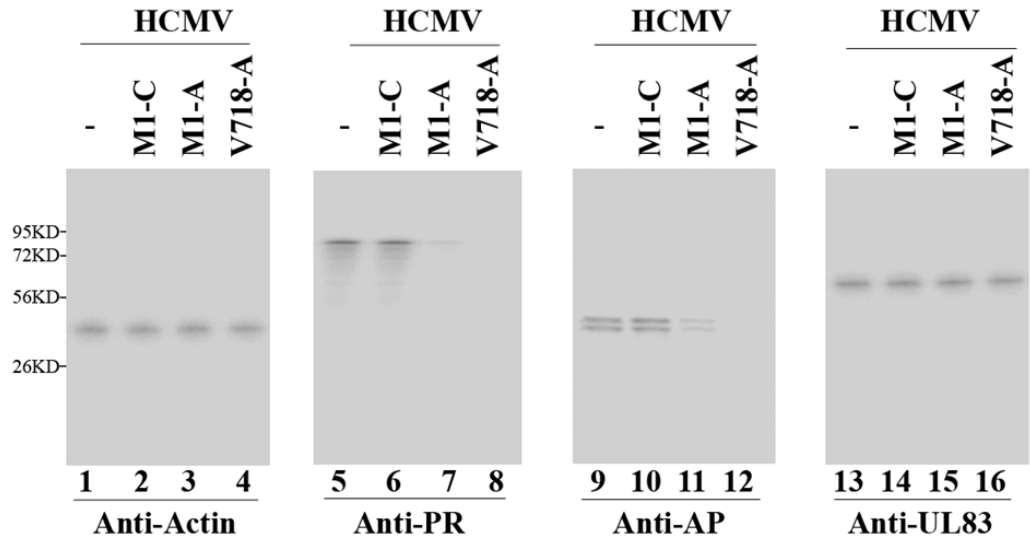
Figure 4. Western blot analyses of the expression levels of HCMV proteins. Protein samples